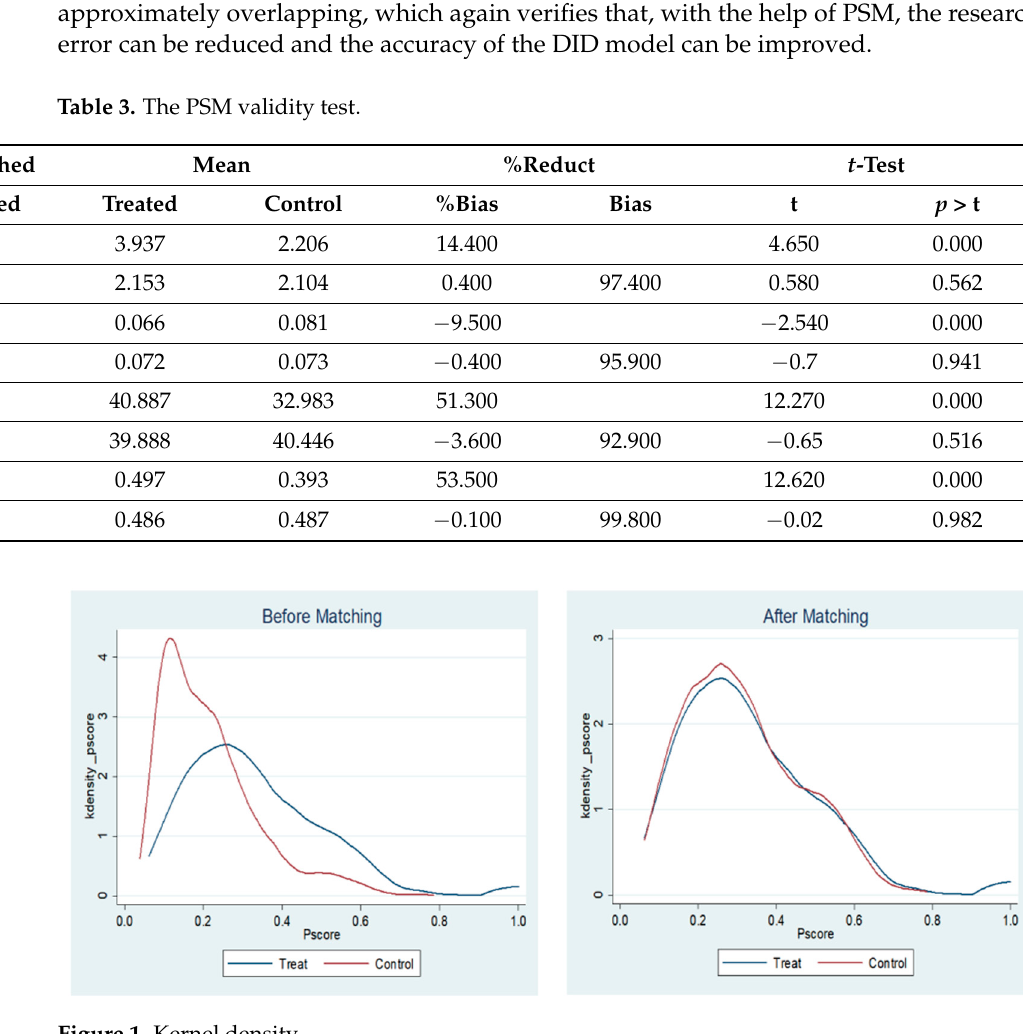
Figure 1. Kernel density.